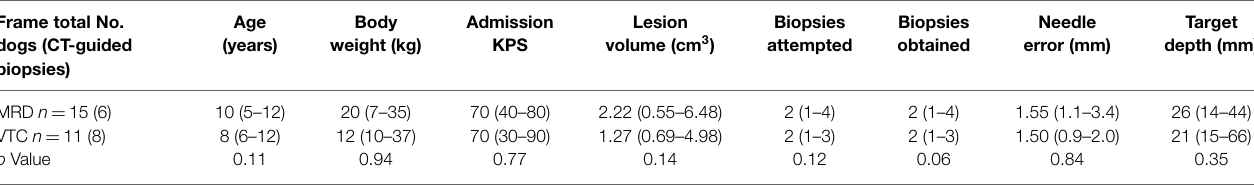
TABLE 2 | Summary of continuous patient, lesion, and biopsy variables by headframe type . Frame total No. dogs (CT-guided